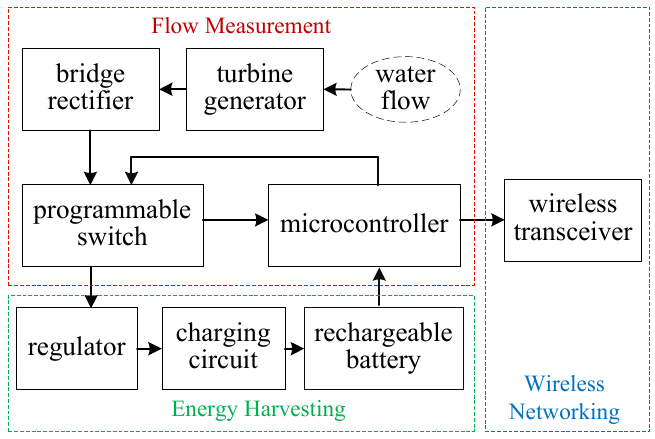
Figure 3. Block diagram of the smart